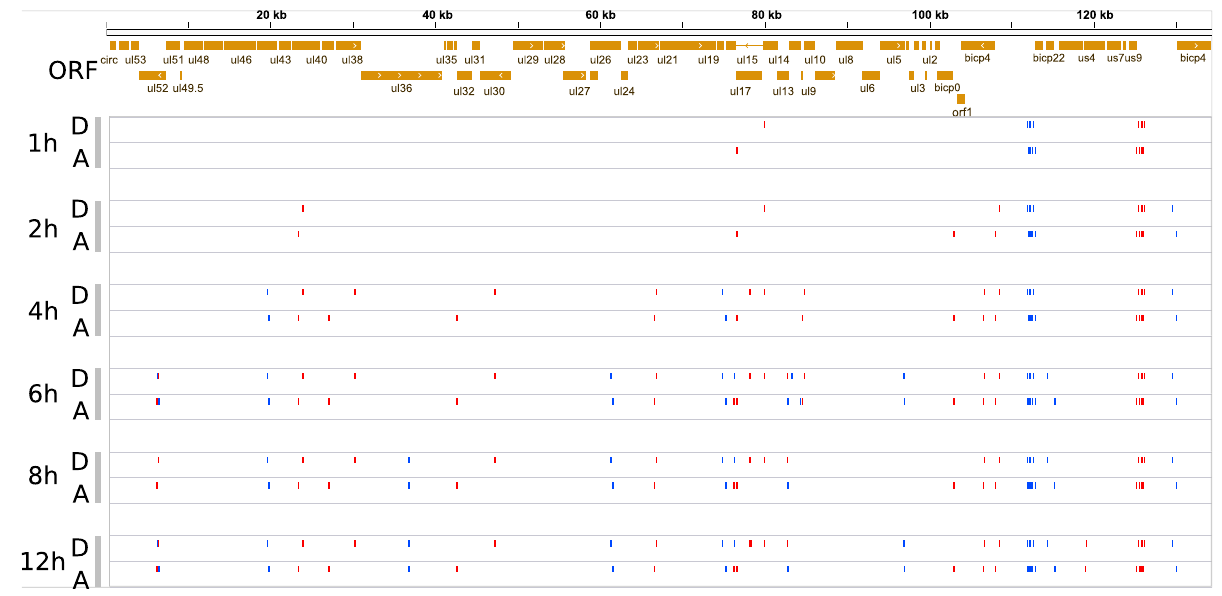
Figure 6. Genome-wide kinetics of splice junctions of the BoHV-1. Blue dashes represent splice junctions on the forward strand, whereas red dashes represent splice junctions on the reverse strand. Sites are plotted in two rows per sample, ‘D’ represents the donor, and ‘A’ represents the splice acceptor sites. Orange rectangles illustrate the ORFs. Splice junctions were detected using the LoRTIA software